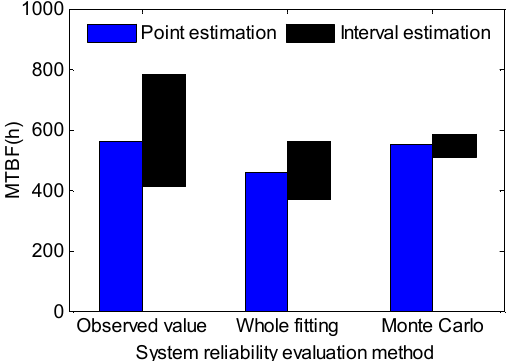
Figure7. Point estimation and interval estimation of the different methods. Figure 7. Point estimation and interval estimation of the different